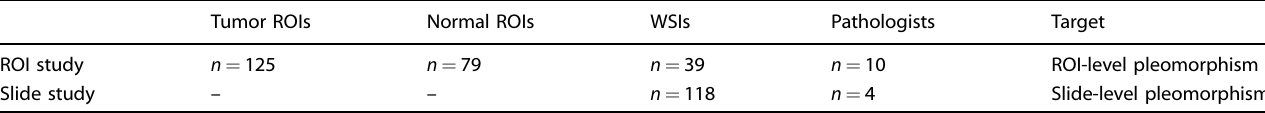
Table 1. Overview of the number of regions of interests (ROIs), whole-slide images (WSIs), and pathologists involved in the two reader studies of this work, namely the ROI study and the slide